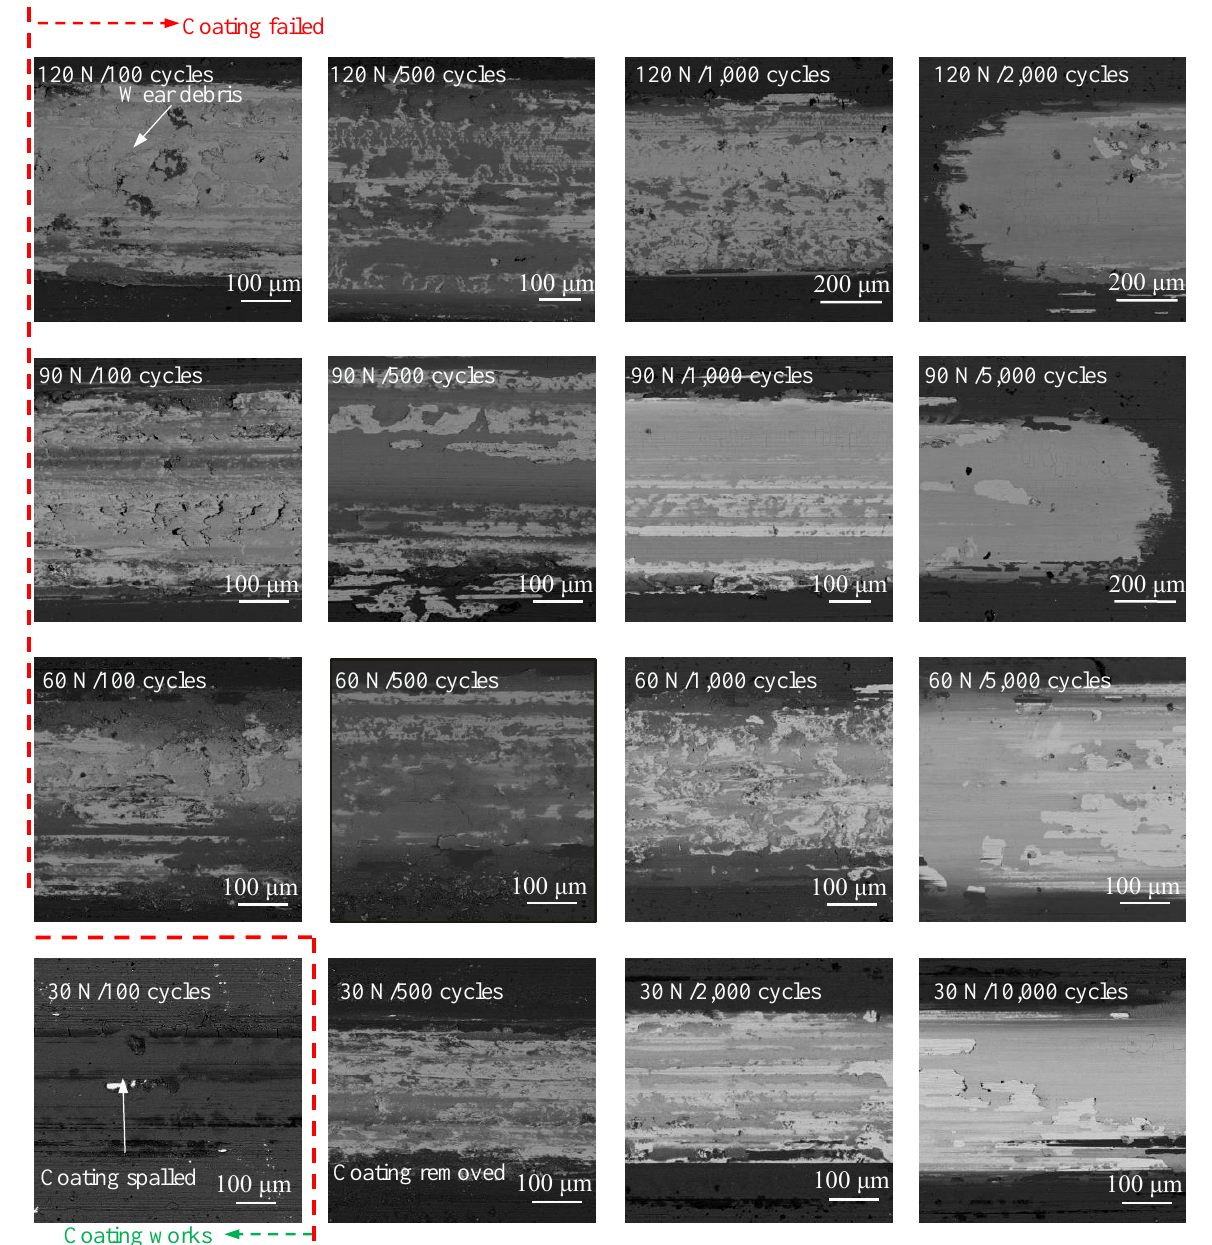
Figure 13. Wear and failure process of AlTiN coated HSS substrate under different normal forces.